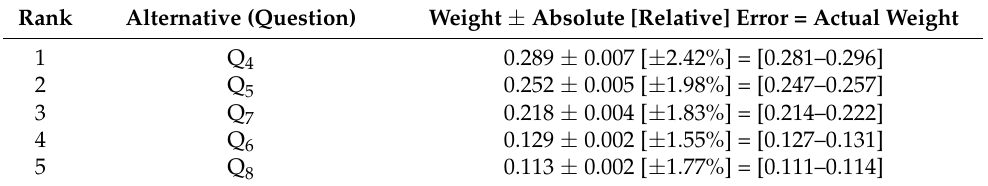
Table 7. Alternatives’ weights and mean errors.